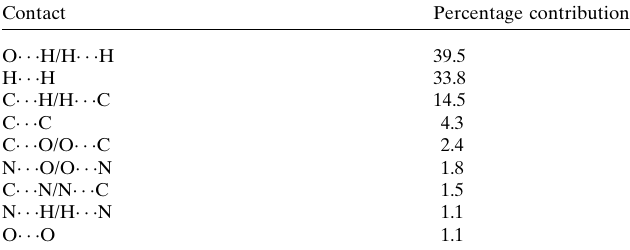
Table 2 Percentage contributions of interatomic contacts to the Hirshfeld surface for the title compound.